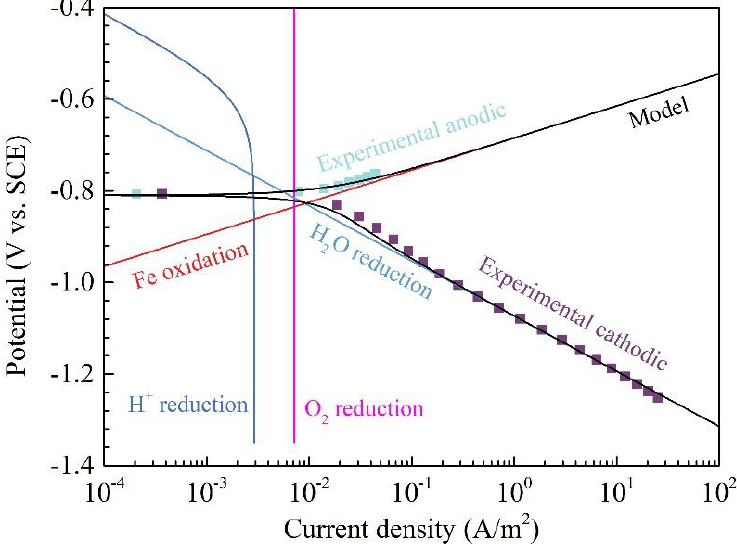
Figure 3. The polarization curves and modeling results of Q345R steel in 1 wt.% NaCl solution containing 0.08 mg/L oxygen, with pH 6.0 at 30 °C. Square: experimental data. Solid line: modeling result.